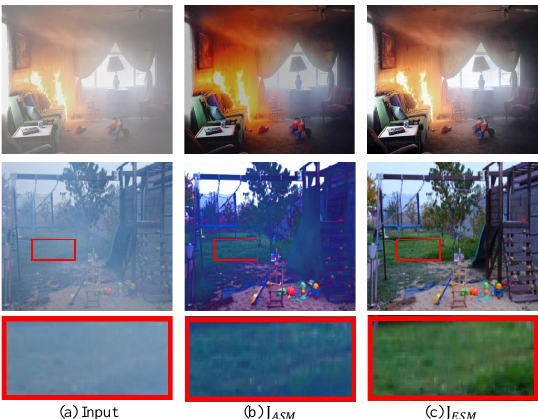
Figure 4. The effectiveness of the ESM on real-world images. The dehazed results of J ESM are much clearer than J ASM